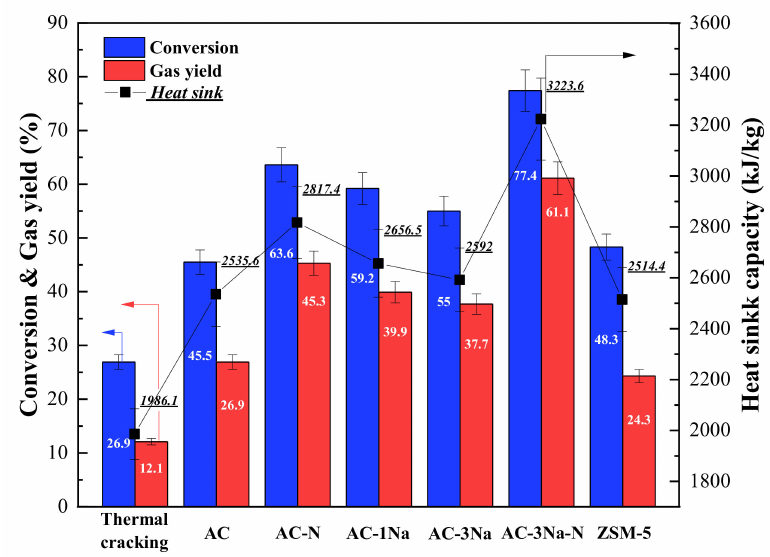
Figure 6. Conversion, gas production yield, and heat sink capacity at 450 ◦ C and 4 MPa.